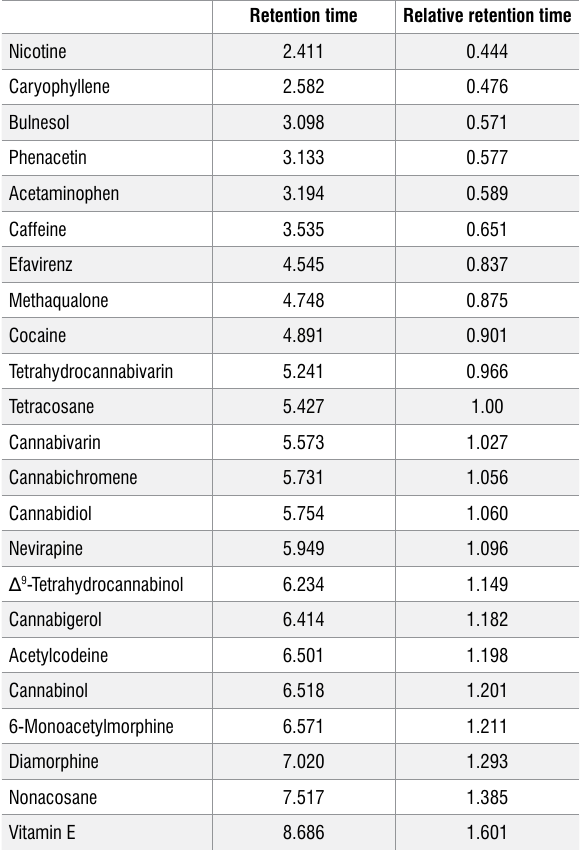
Retention time and relative retention time for the compounds identified in the analysis of simulated and casework nyaope samples. Identifications were made on the basis of retention indices and mass spectra of standards and casework